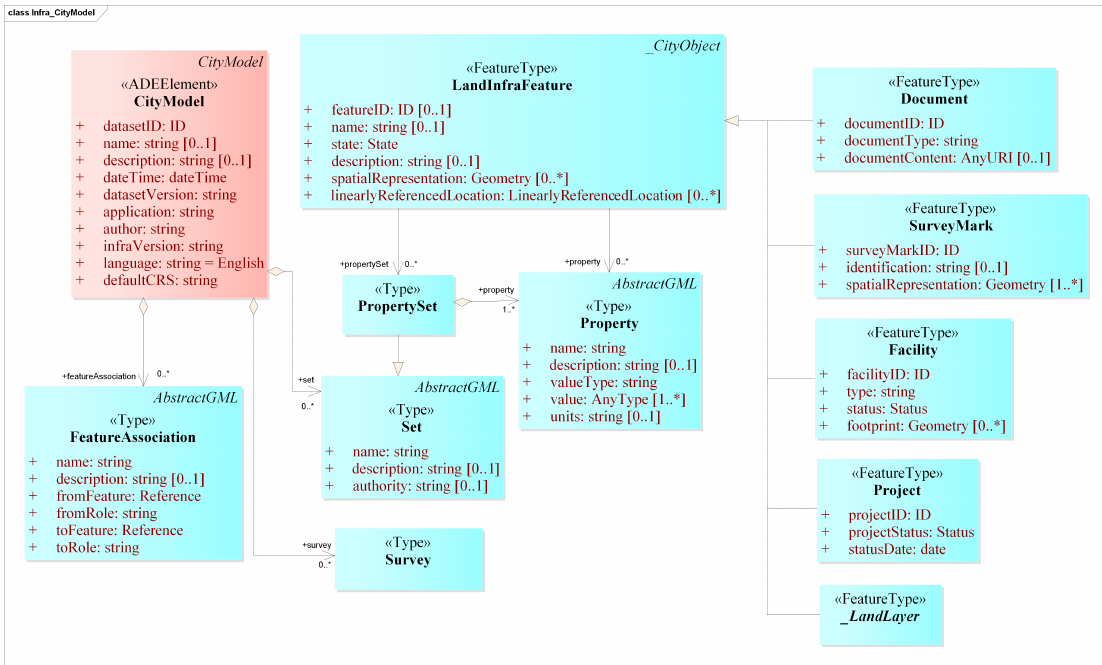
Figure 1. The Unified Modelling Language (UML) excerpt depicts extended City Geography Markup Language (CityGML) class CG::CityModel (marked with stereotype «ADEElement») to include attributes from LandInfra class LI::LandInfraDataset . The LandInfra classes such as Facility , Project , LandFeature , Document , SurveyMark , and _LandLayer , which do not have a corresponding match in CityGML are introduced in the Infra Application Domain Extension